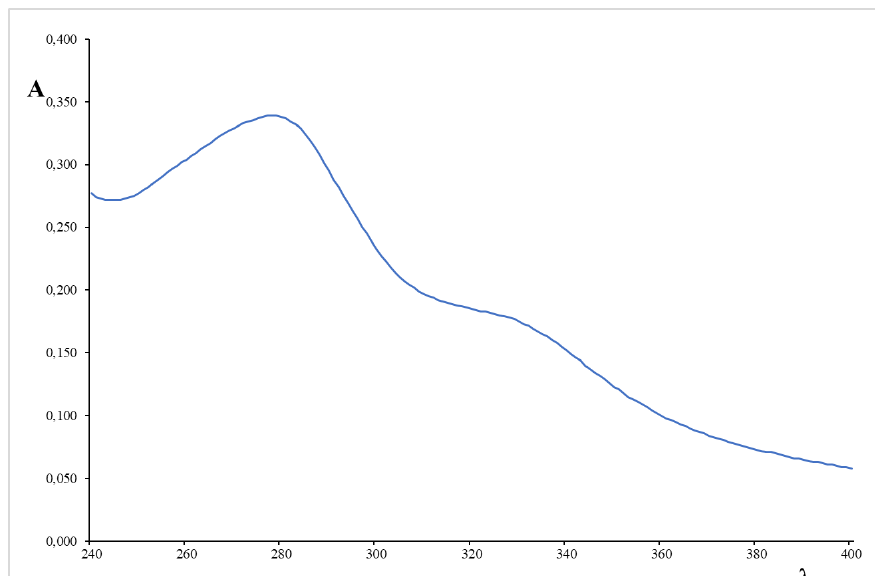
Fig. 7 Absorption spectrum of phenylalanine-modified Arctostaphylos uva-ursi leaves